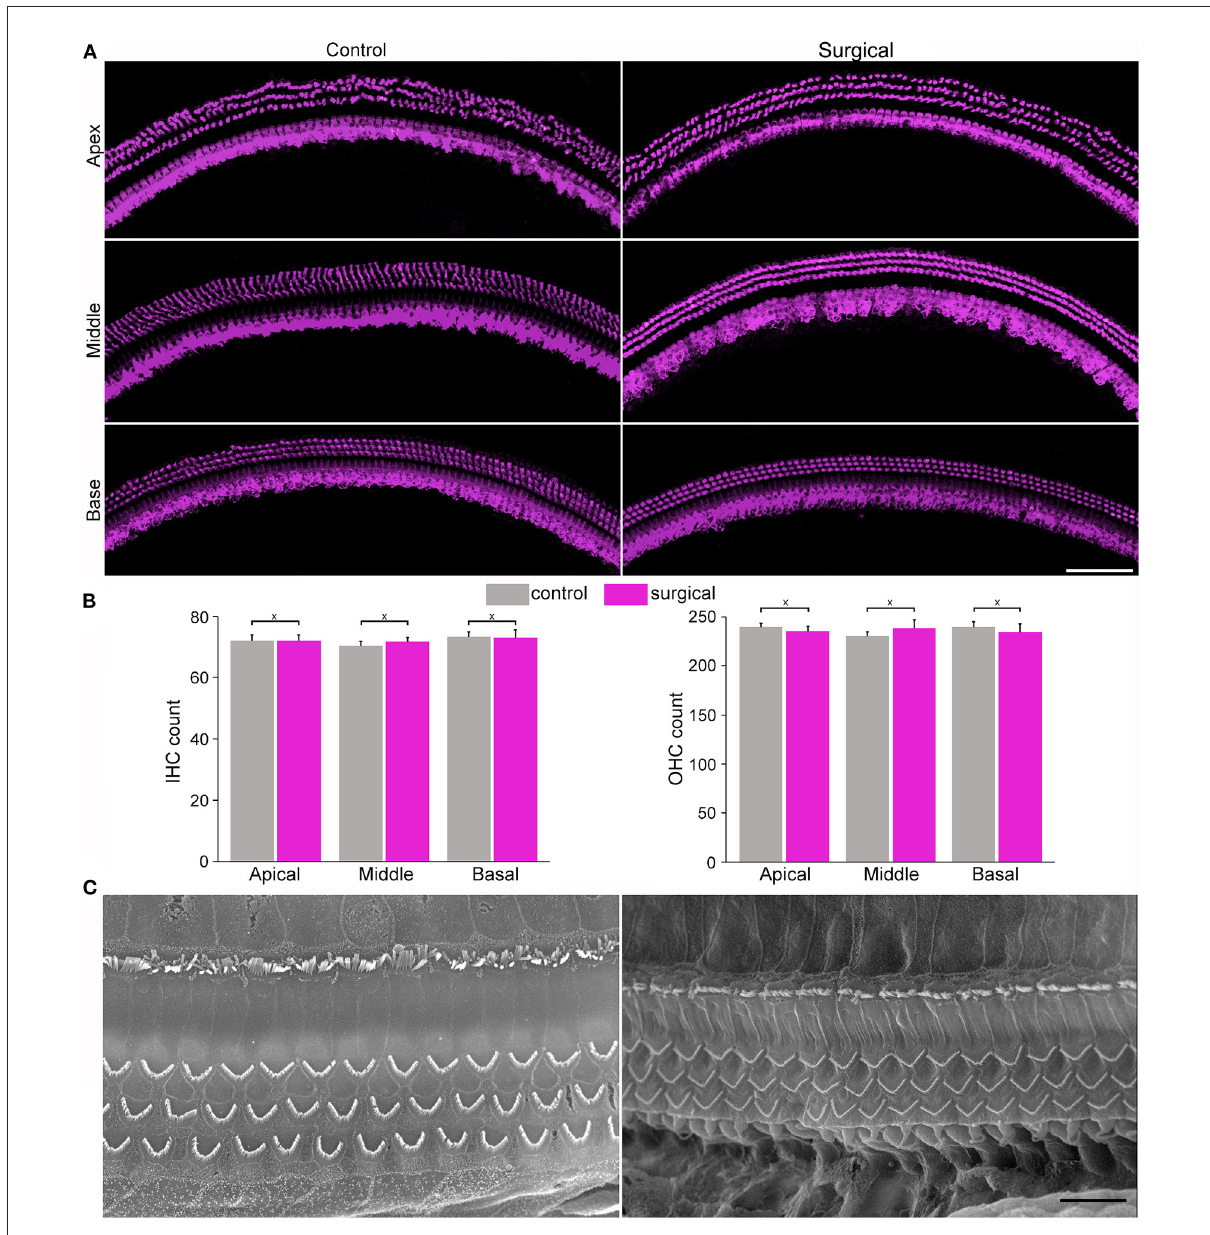
FIGURE2 Images from confocal and scanning electron microscopy and morphology of cochlear hair cells and stereocilia. (A) Representative confocal images of hair cells from apical, mid- and basal regions of the cochleae from control and surgical ears with occlusion 28 days after surgery (surgical ear was used in all subsequent figures to represent occlusion of two semicircular canals). Bar: 75 µ m. (B) IHC and OHC count from control and surgical ears. Data are presented as the mean ± SD, n = 3. X represents no statistical significance between the two groups ( p = 0.83, 0.35 and 0.86 for apical, middle and basal turn for IHC count, respectively. p = 0.34, 0.22, and 0.44 for apical, middle and basal OHC count, respectively). (C) Representative SEM micrographs of stereocilia bundles of hair cells from apical and basal turns of the surgical ear. Bar: 10 µ m.